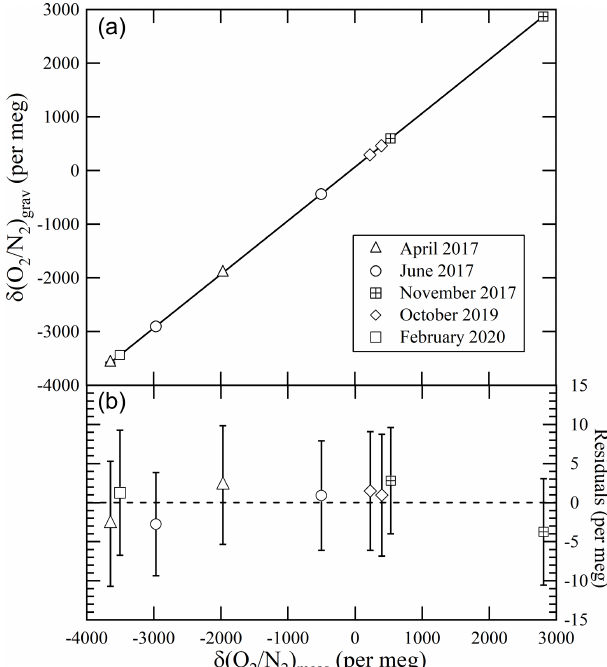
Figure 2. (a) Relationships between the gravimetric values of δ (O 2 / N 2 ) in nine high-precision standard mixtures prepared from April 2017 to February 2020 and the δ (O 2 / N 2 ) values measured using the mass spectrometer at EMRI/AIST. (b) Residuals from the line of the Deming least-square fit to the plots. The error bar repre- sents the expanded uncertainty of the δ (O 2 / N 2 ) NMIJ/AIST